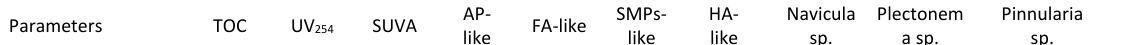
Table 2: The degree correlation among the bulk parameters, fluorescence organic matter, and phytoplankton abundance*